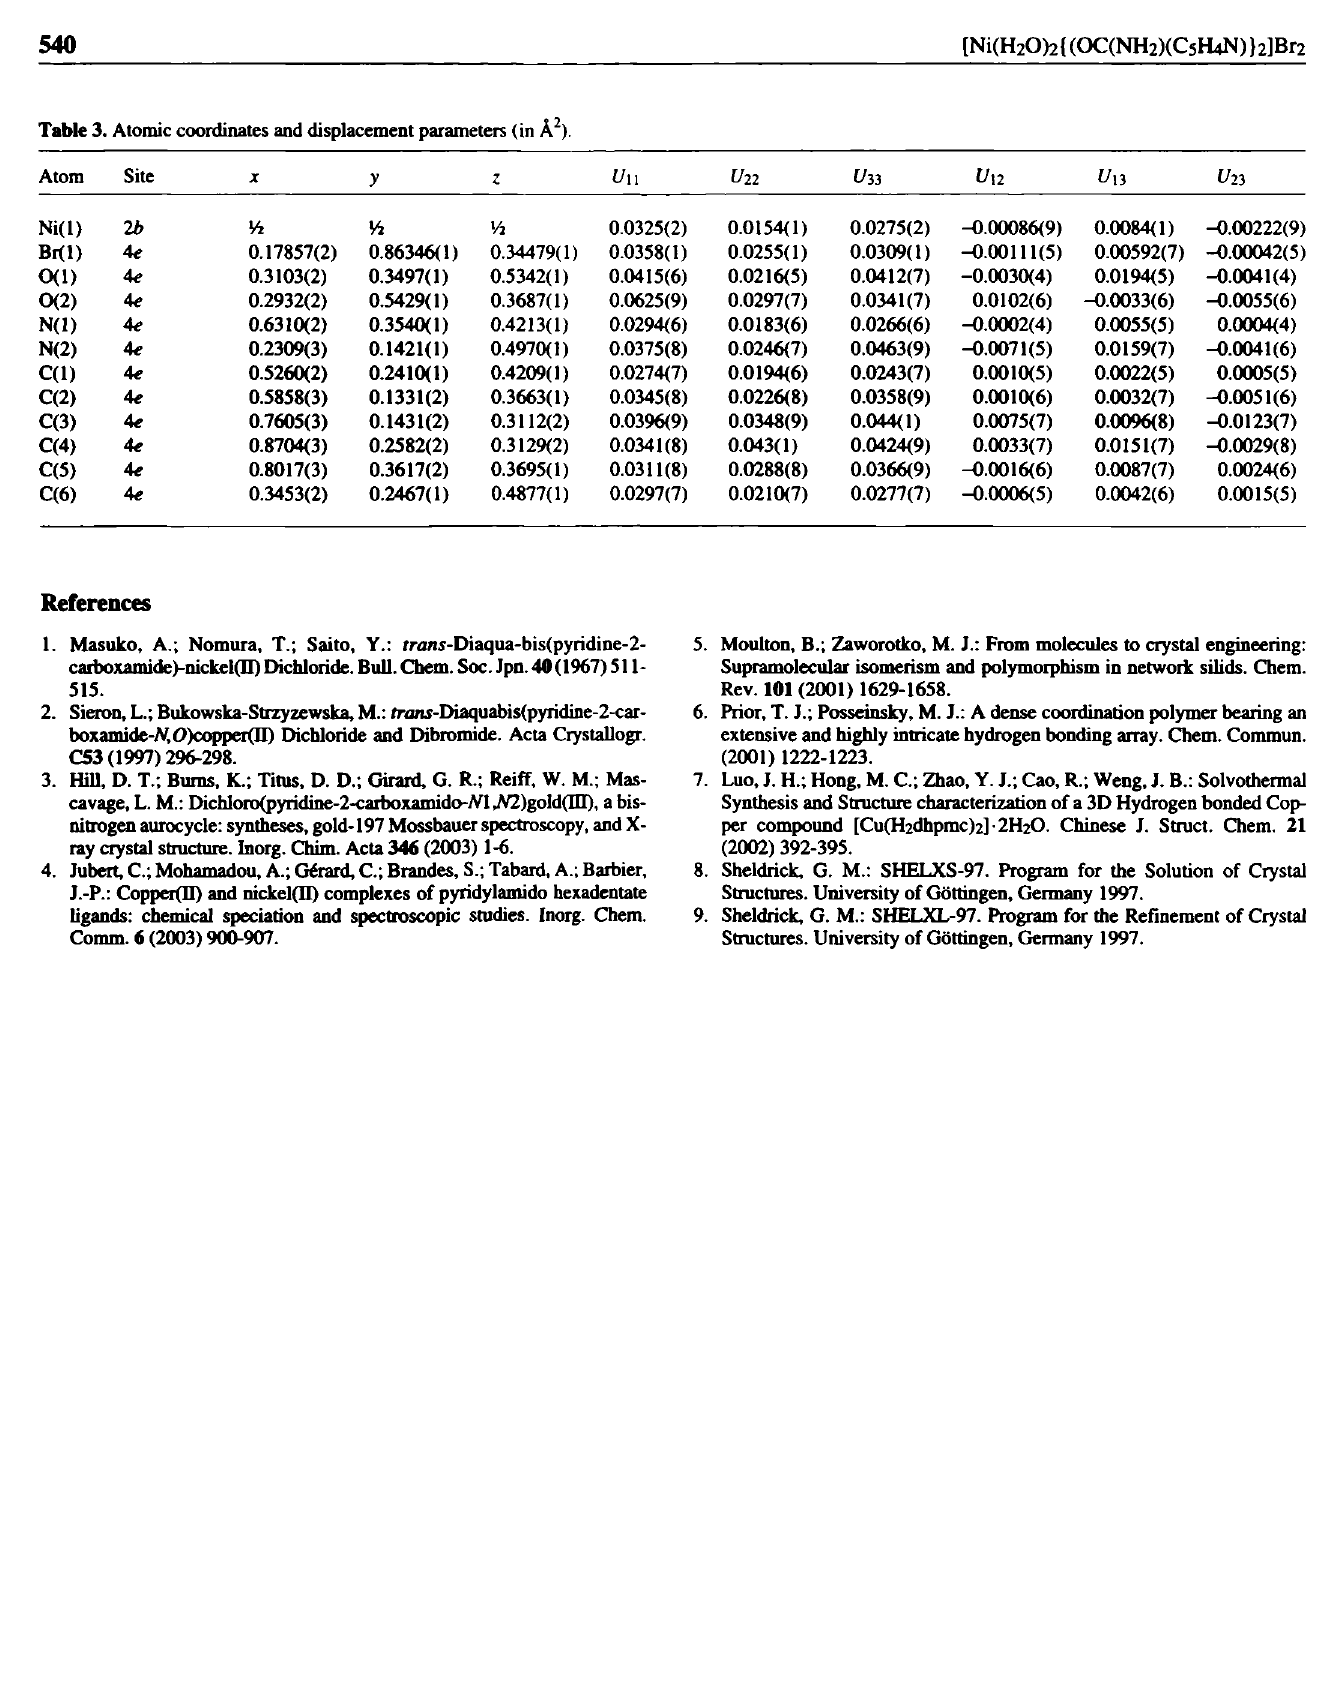
Table 3. Atomic coordinates and displacement parameters (in A 2